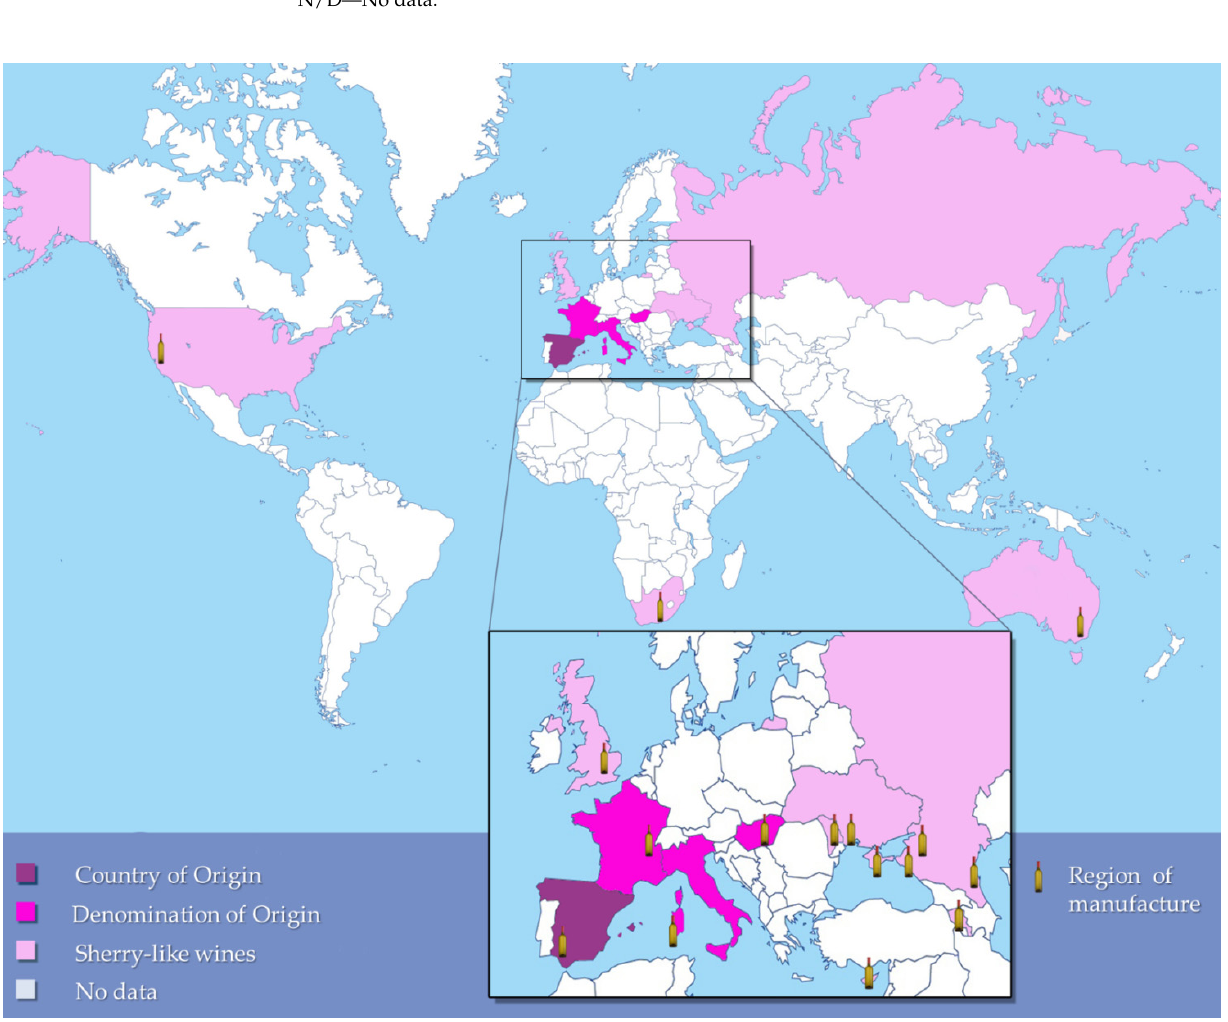
Figure 1. Worldwide production of sherry and sherry-like wines. Spain, the origin of sherry wines— colored in dark purple; countries with registered Denominación de Origen (DO) production of sherry wines—colored in fuchsia; countries that produce sherry-like wines—colored in light pink; countries for which there are no data on the production of sherry-like wines—colored in white. The bottle icon indicates the region in which the sherry or sherry-like wine is produced. Table 1. Major sherry and sherry-like wine production worldwide and their analytical characteristics.